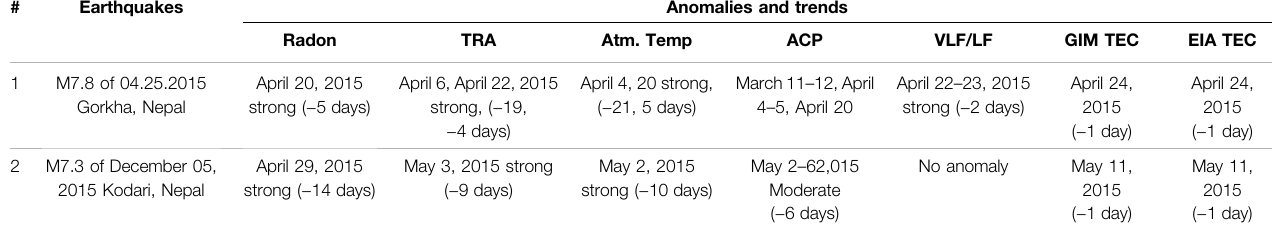
TABLE 1 | Detection of joint anomalies for the M7.8 of 04.25.2015 Gorkha, Nepal and M7.3 of December 05, 2015 Kodari, Nepal.